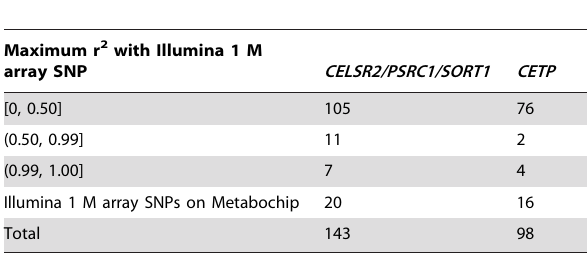
Table 1. Coverage of 2 Metabochip regions by SNPs on the Illumina 1 M GWAS array.